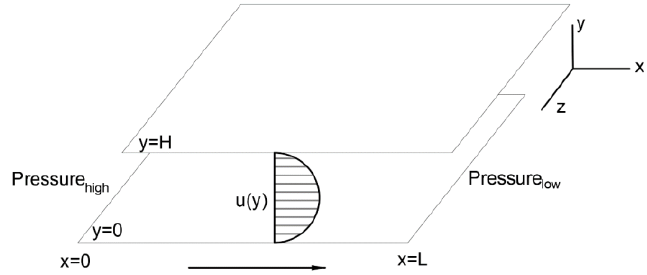
Figure 8. Poiseuille flow.